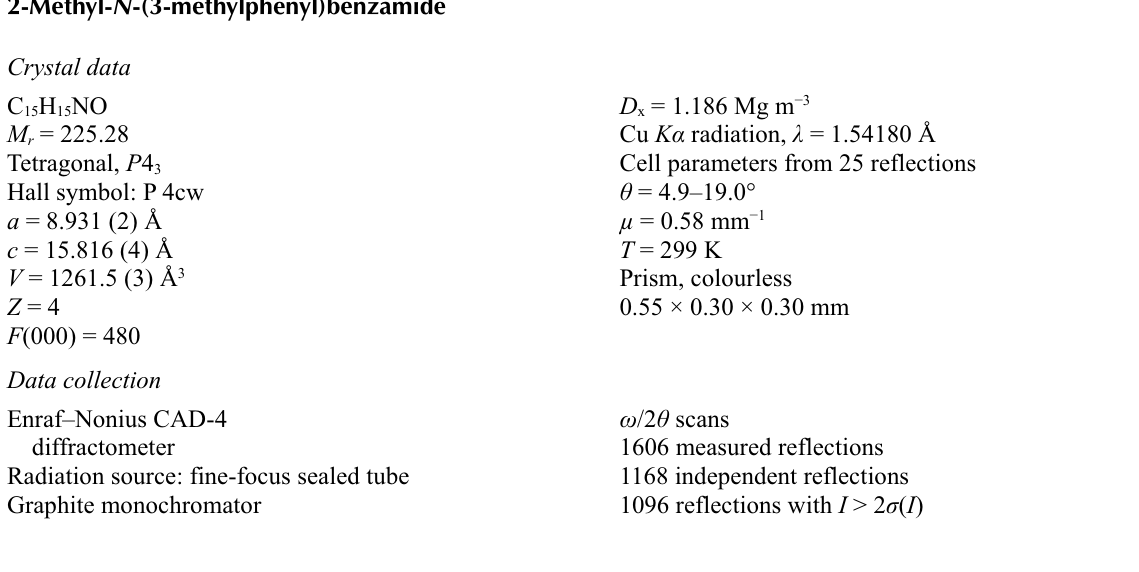
Figure 2 Molecular packing of the title compound with hydrogen bonding shown as dashed lines. 2-Methyl- N